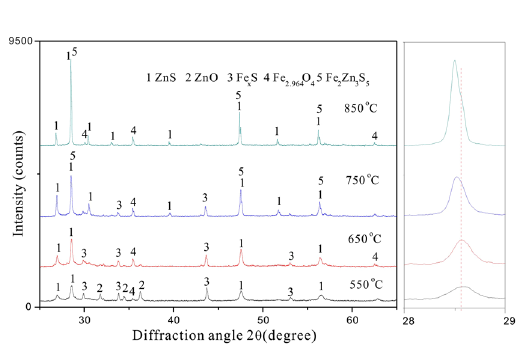
Figure 4. TG curves of the sample with respect to time and temperature (n FeS2 :n ZnO = 1:1).